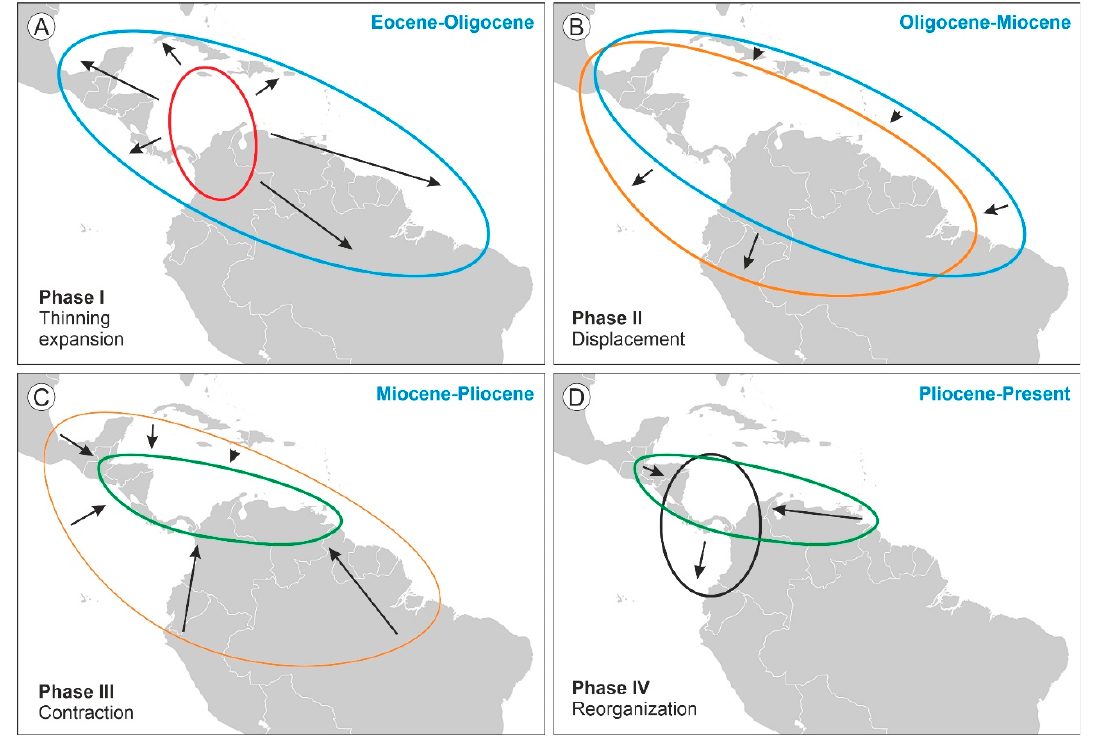
Figure 4. Pelliciera range shifts between the Eocene and the present subdivided into four chronological phases. ( A ) Phase I, thinning expansion (Eocene-Oligocene). ( B ) Phase II, displacement (Oligocene-Miocene). ( C ) Phase III, contraction (Miocene-Pliocene). ( D ) Phase IV, reorganization (Pliocene-Present).